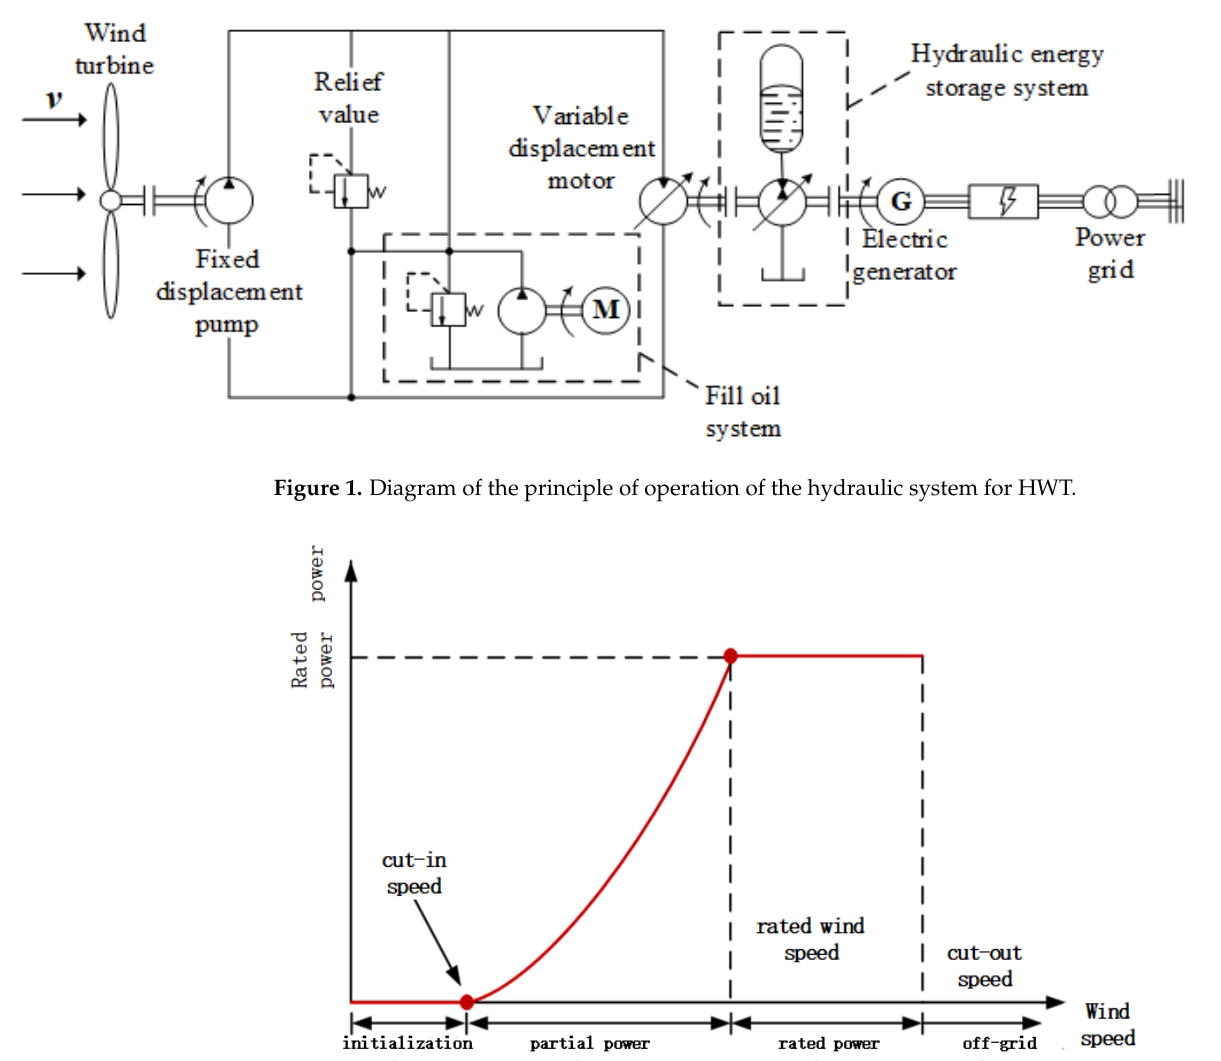
Figure 1. Diagram of the principle of operation of the hydraulic system for HWT.